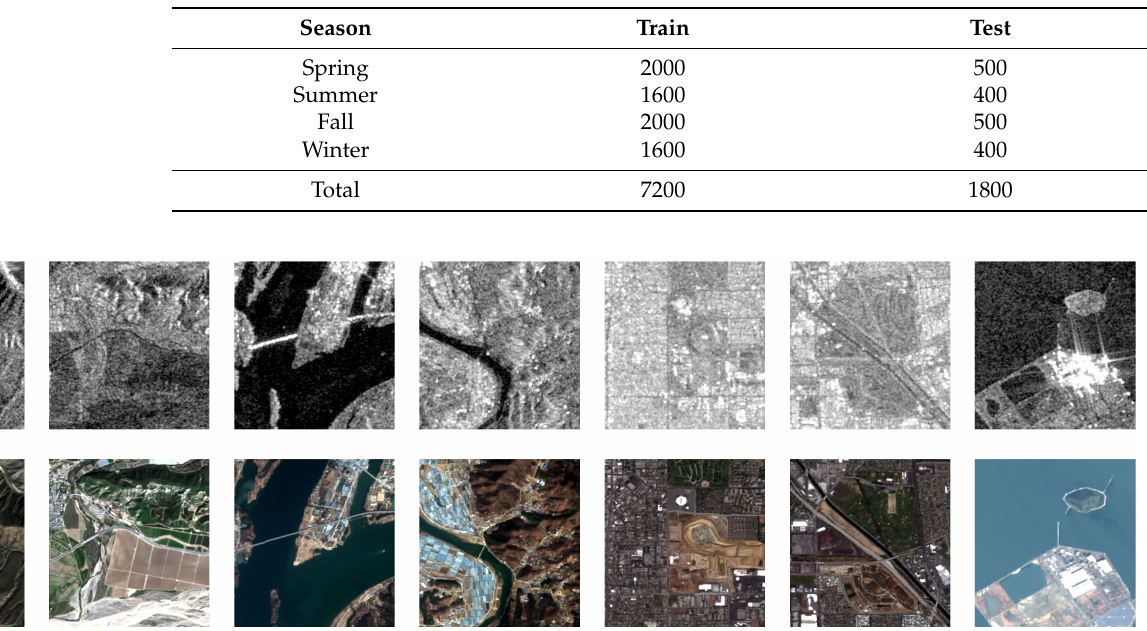
Figure 6. The examples of the SEN1-2 dataset. The first row is SEN-1 data, representing SAR images, and the second row is SEN-2 data, representing optical RGB images. Best viewed in